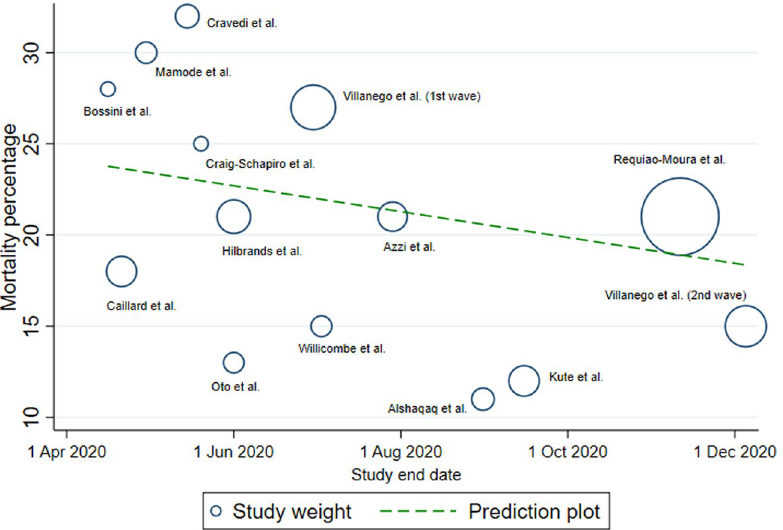
Figure 2. Bubble plot of actual mortality percentage and study end date, with the predicted regression line from a generalized linear model. Bubble size is proportional to the total number of participants in the